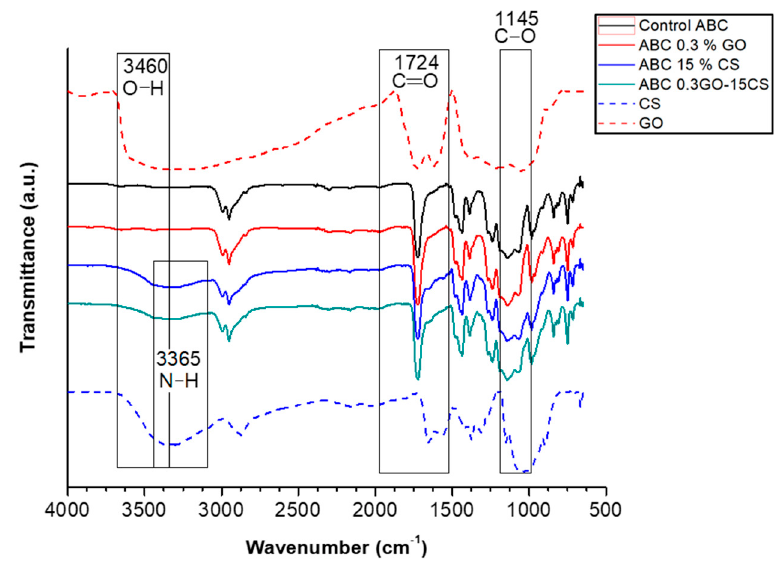
Figure 2. ATR-FTIR spectra of ABCs, CS, and GO. Control ABC corresponds to ABC without fillers.